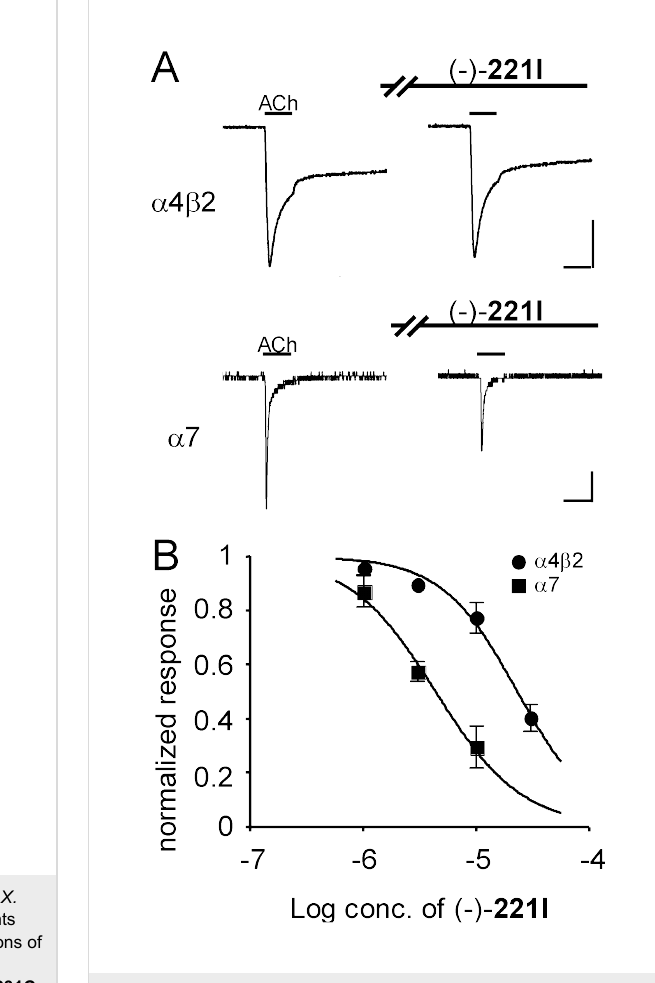
Figure 2: Inhibitory effect of (-)- 221I on ACh-induced currents in X. laevis oocytes expressing recombinant nicotinic receptors. Currents were recorded in the voltage-clamp mode at -60 mV. Concentrations of ACh used were 1 μM for the α4β2 receptor and 100 μM for the α7 receptor. For test responses, oocytes were preincubated with (-)- 221I for 3 min and then exposed to ACh with (-)- 221I . A, representative traces showing the ACh-elicited currents in the absence and presence of (-)- 221I (3 μM). Horizontal bars indicate the period of perfusion with ACh for 5 s. Vertical scale bars represent 0.5 μA on the α4β2 receptor, and 0.1 μA on the α7 receptor. B, concentration-response curves for (-)- 221I on recombinant nicotinic receptors. Current responses to ACh in the presence of (-)- 221I in each oocyte were normalized to the ACh responses (control responses) recorded in the same oocytes. Values represent the mean ± S.E.M. for five separate